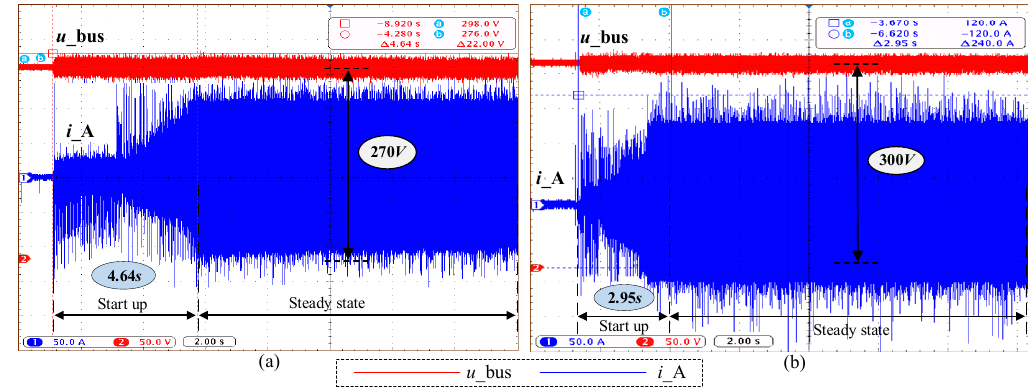
Figure 11. Bus-voltage and phase-current waveforms in transient process. ( a ) Normal mode; ( b ) manual boost mode ( K 1 = 1).